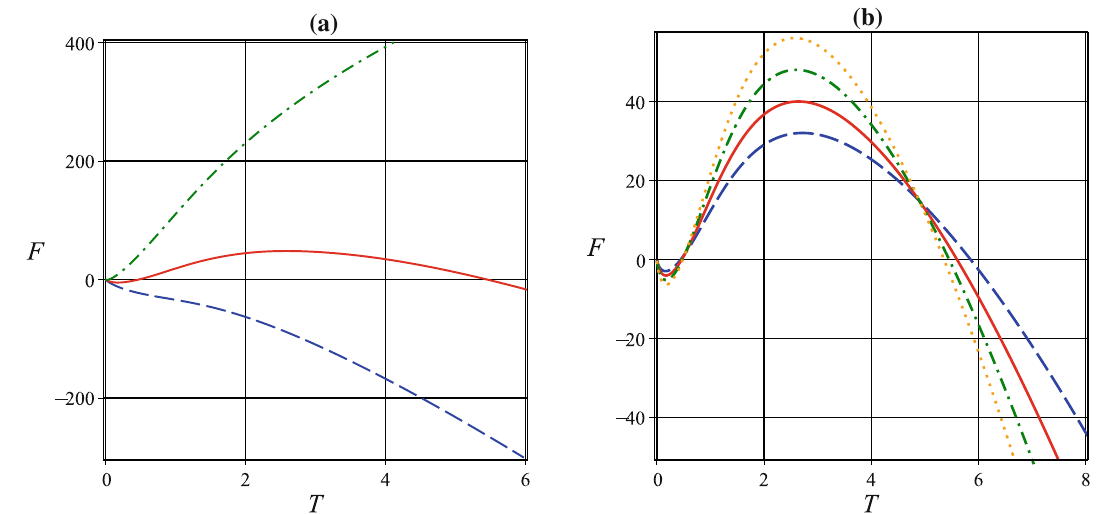
Fig. 1 Typical behavior of the Helmholtz free energy in terms of T . (a) N l = 3 (blue dash), N l = 4 (red solid), N l = 5 (green dash dot); l = 1 , 2 , 3 , 4 , 5. (b) N l = 4; l = 1 , 2 , 3 (blue dash), l = 1 , 2 , 3 , 4 (red solid), l = 1 , 2 , 3 , 4 , 5 (green dash dot); l = 1 , 2 , 3 , 4 , 5 , 6 (orange dot)